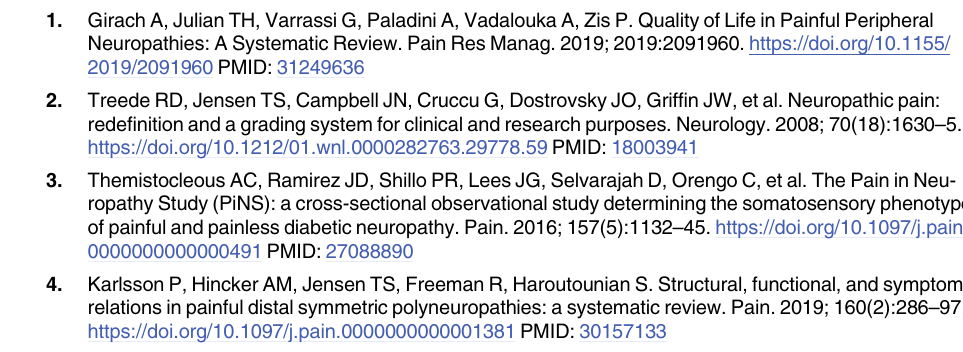
pulses of 0.8 and 1 mA. Patients are grouped “hyper-responsive” (solid squares”), “hypo- responsive” (open squares) or “normal responsive” (open circles) to transcutaneous electrical stimuli. S2 Fig. Spearmans rank correlation. Analysis between pain from neuropathic skin sites (delta NRS neuropathy vs. control) and acute (spontaneous) pain (left panel) or maximum pain per- ceived during 7 days (right panel) upon (A) 2.5 sec 4 Hz sinusoidal pulses of 0.2 and 0.4 mA, (B) within the last 30 sec of 1 min 4 Hz supra-threshold sinusoidal pulses, and (C) upon 500 ms single half sine wave pulses of 0.8 and 1 mA. A significant correlation was identified between neuropathic skin site pain upon half sine wave stimulation and the 7-day maximum pain (p < 0.05). Scatterplot depicts patients’ groups by their lidocaine-patch response of acute (spontaneous) “pain-amelioration” (solid squares), “pain elevation” (open squares) or “no change” (open circles), respectively. S1 Table. Data correlation. (A) Spearmans rank correlation between sensory profiles and NRS scores. (B) Spearmans rank correlation between questionnaire scores (HADS and SF-12) and acute (spontaneous) pain, 7-day pain, and electrically evoked pain in neuropathic (NP) and control (ctr)